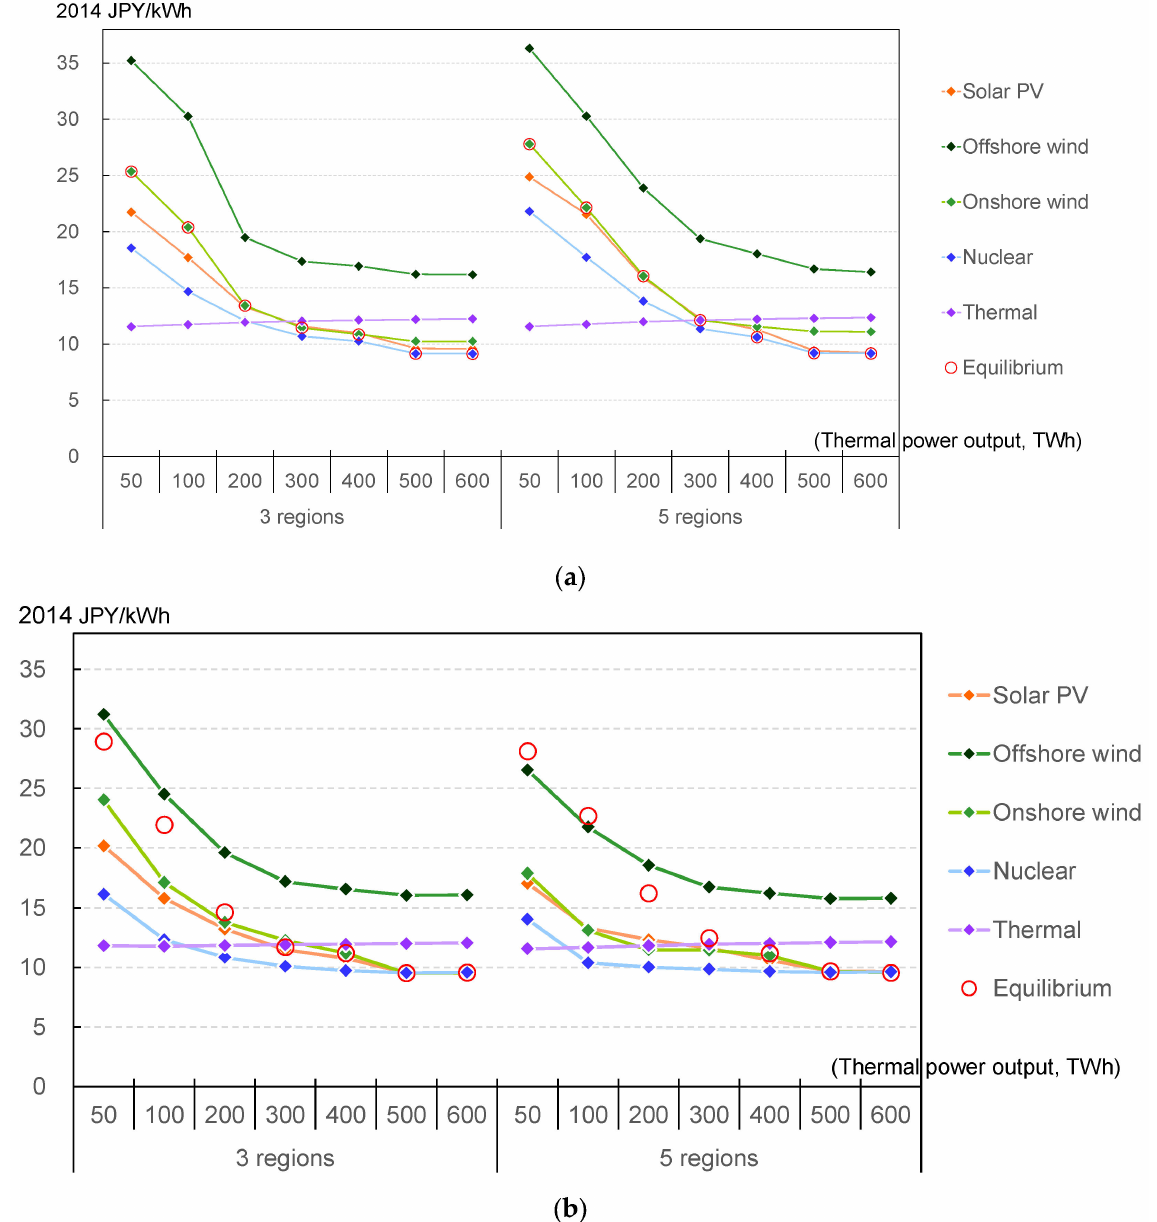
Figure 6. Marginal system LCOE (Case 7: 2017 data). ( a ) Maximum; ( b )